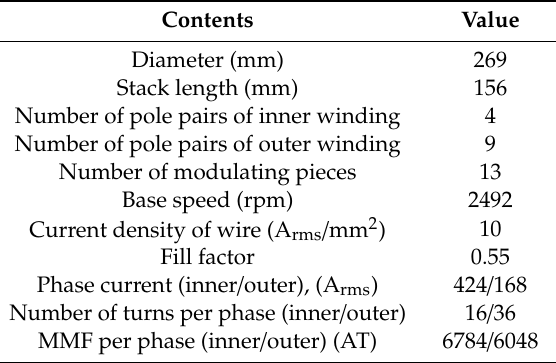
Table 1. Specifications of the analysis